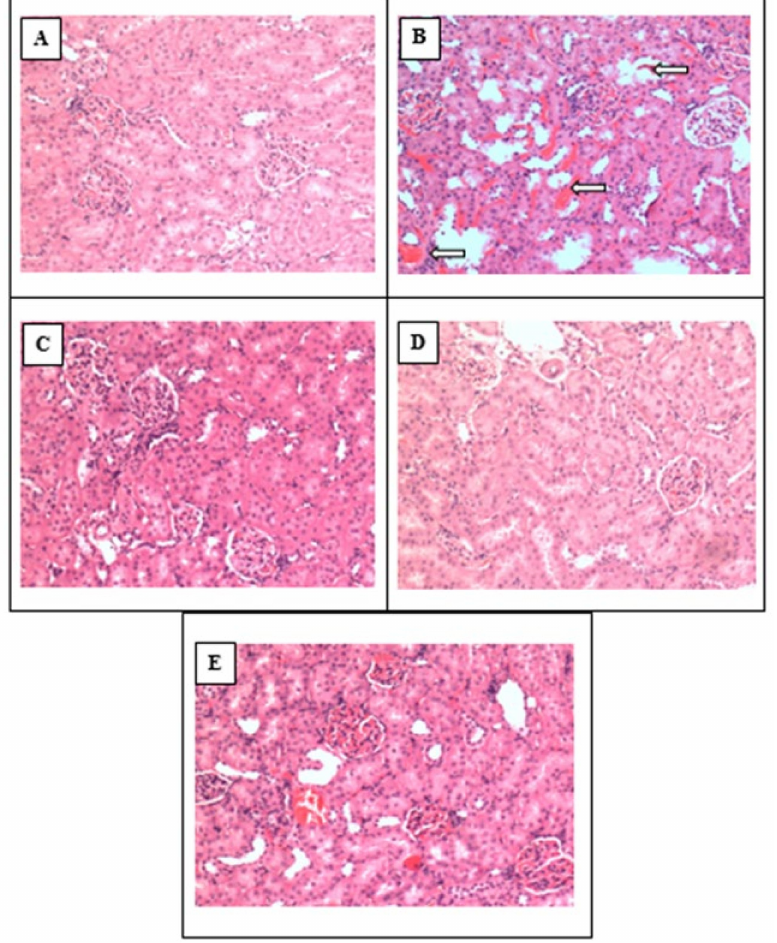
Figure 7. Histopathology study of kidneys from ( A ) control, ( B ) renal ischemic-reperfusion injury, ( C ) sham-control, ( D ) H 2 S-treated and ( E ) renal ischemic-reperfusion injury treated with H 2 S rats (magnification: 10 ×